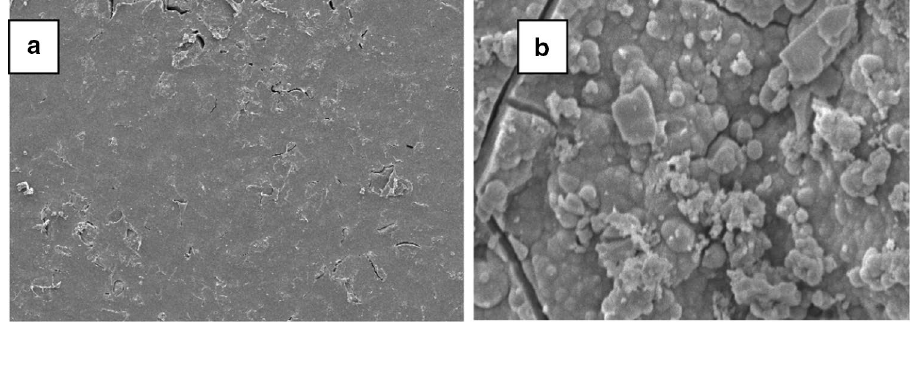
Fig. 10 a SEM image of raw CEM and b used CEM facing cathode